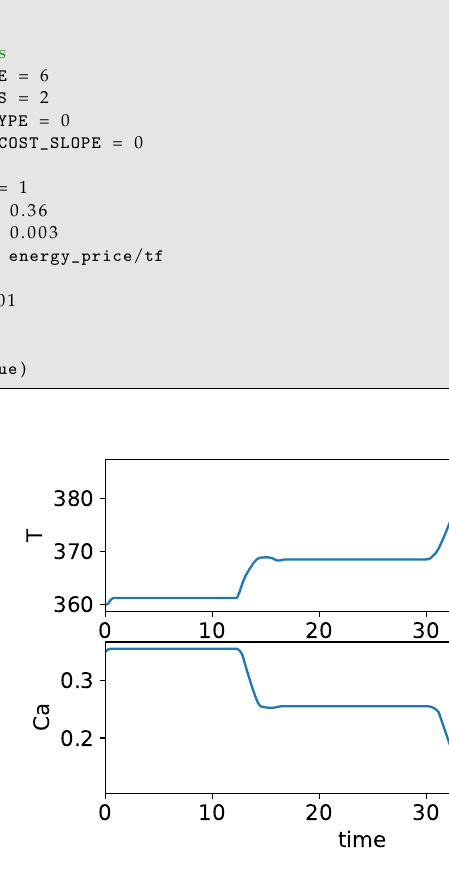
Figure 4. Combined scheduling and control problem